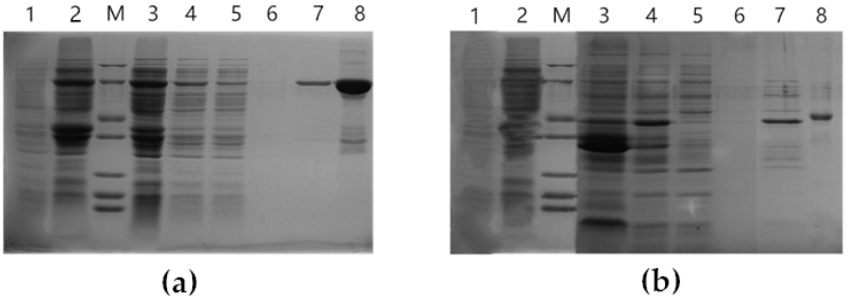
Table 1. Analysis of ZbDXS and ZbFPS in vitro